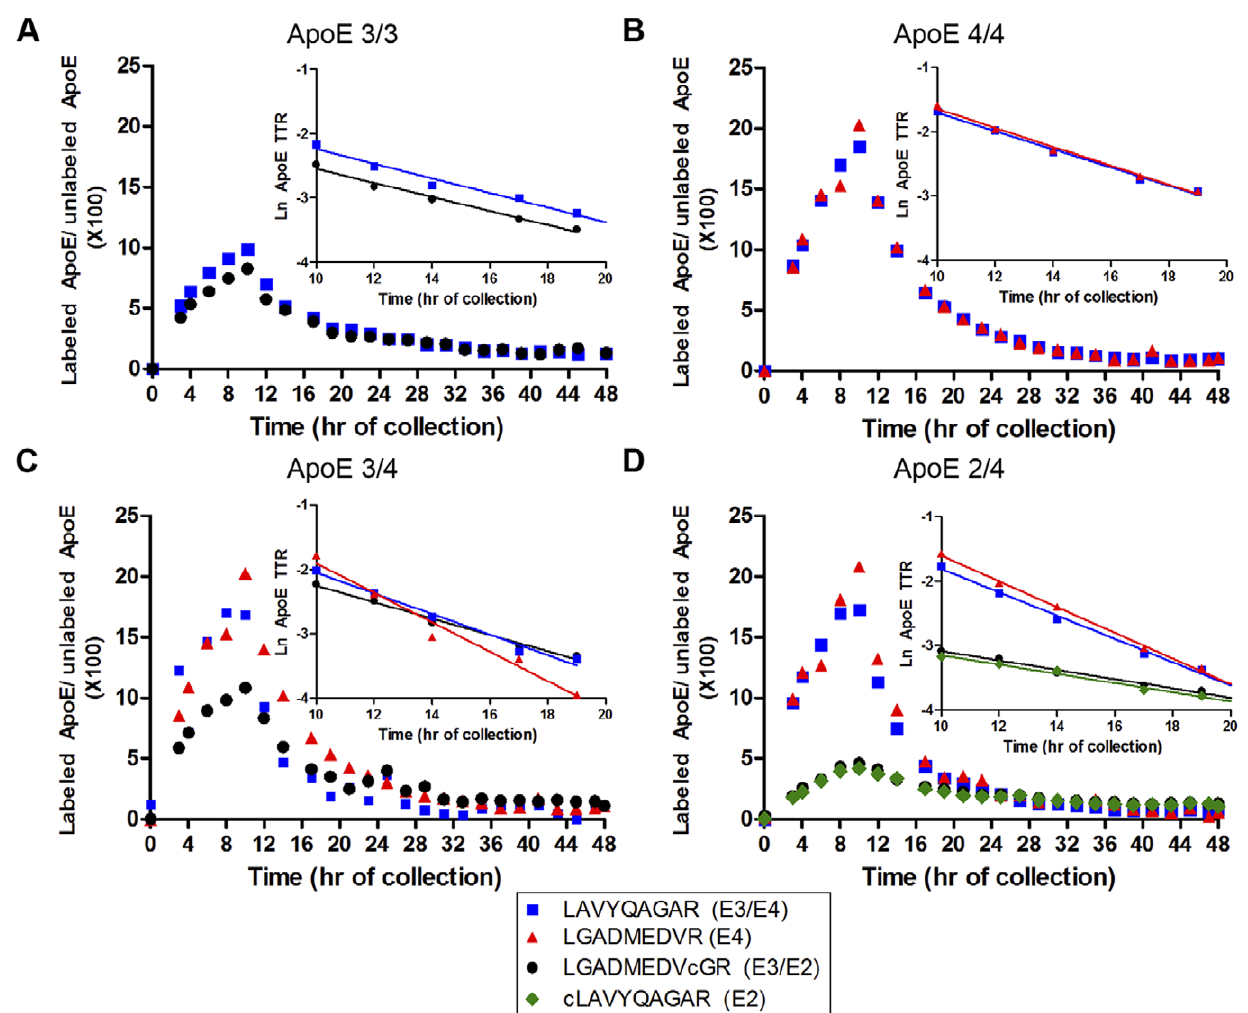
Figure 1. Plasma ApoE Isoforms have different turnover kinetics(ApoE4 . ApoE3 . ApoE2). 13 C 6 -leu incorporation into plasma ApoE isoforms was analyzed from a representative individual for each genotype. The 13 C 6 -leu incorporation peaked at 10 h with ApoE4’s maximum reaching 19.2%, ApoE3 9.9% and ApoE2 4.4%. The different isoforms have different clearance rates as indicated by the slope of the Ln plots (A–D insets). A–D : A , E3/3; B , E4/4; C , E3/4; D , E2/4 (Blue: E3/E4 LAVYQAGAR, black: E3/E2 LGADMEDVcGR, red: E4 LGADMEDVR, green: E2 cLAVYQAGAR).